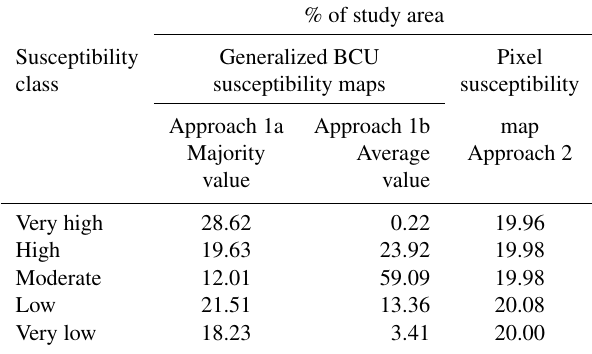
Table 1. Landslide susceptibility classes (%) in the Alenquer study area considering approach 1a (BCU susceptibility generalization considering the majority susceptibility class), approach 1b (BCU susceptibility generalization considering the weighted average sus- ceptibility) and approach 2 (pixel-based susceptibility